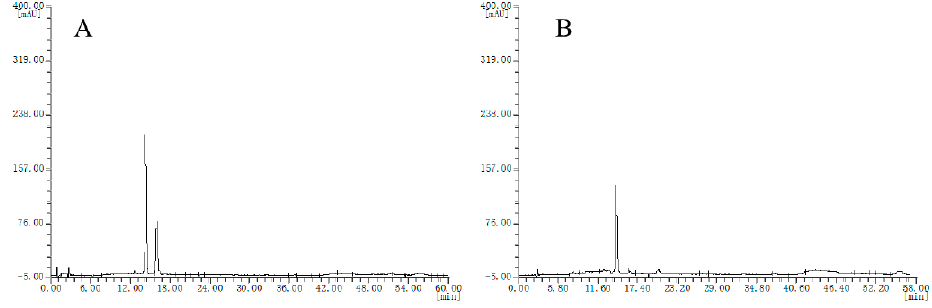
Figure 4. HPLC chromatograms of the cranberry extracts, ( A ), chromatogram type of E1 sample; ( B ) chromatogram type of E2 sample.